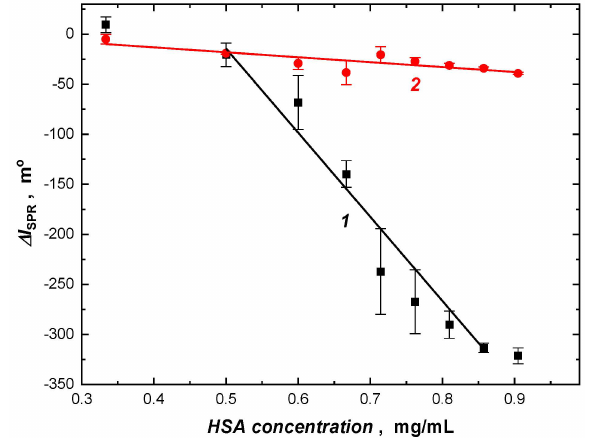
Figure 3. The SPR calibration plots for human serum albumin (HSA), for the (1) MIP and (2) NIP film-coated SPR chips in 0.1 M PBS (pH =